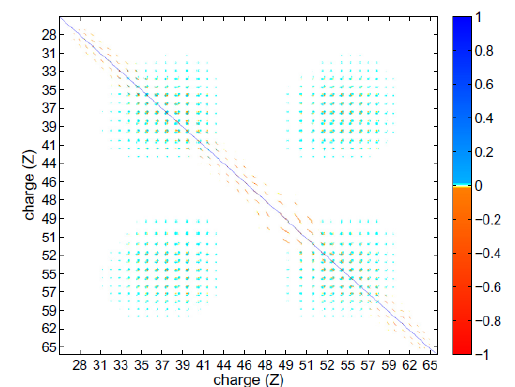
Fig. 8. Correlation matrix of independent yields proposed by L. Fiorito et al. [6, 7]